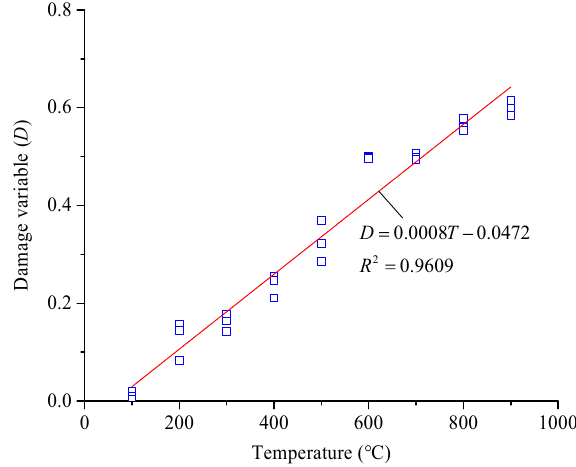
Figure 6. Relationship between the damage variable and the treatment